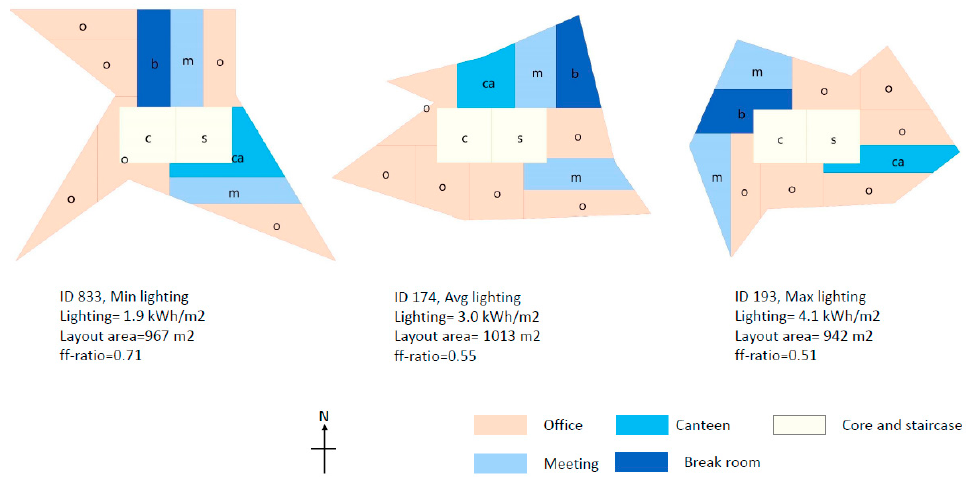
Figure 7. The layout with minimum lighting demand, average lighting demand and maximum lighting demand, resulting from the optimisation for minimising lighting demand. Note: ID is the number of designs in the optimisation.